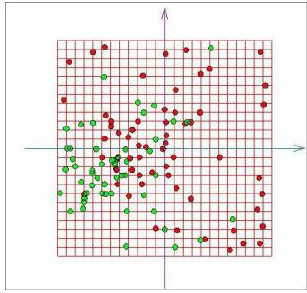
Figure 12. Extension of elastic map for 4-dimensional attribute